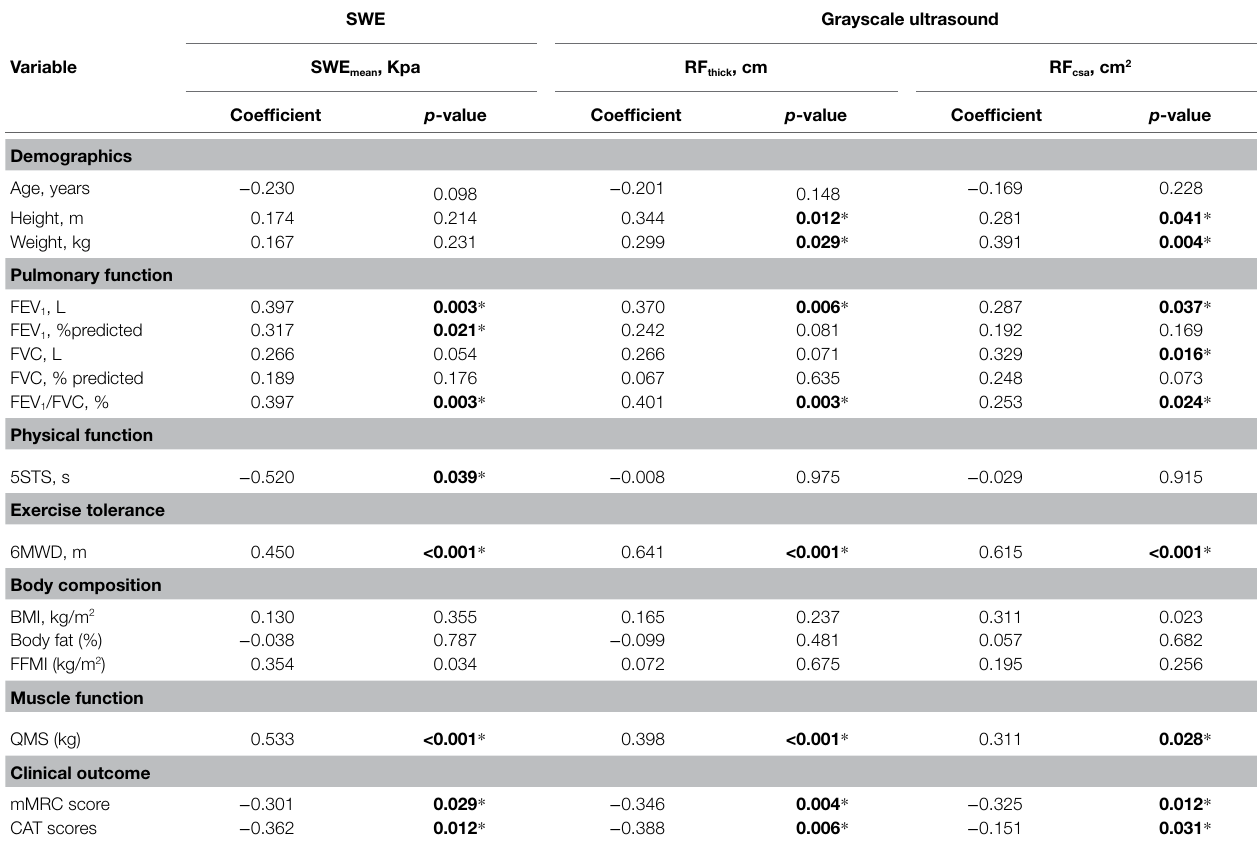
TABLE 3 | Correlations among SWE mean , RF thick, RF csa, and clinical features.